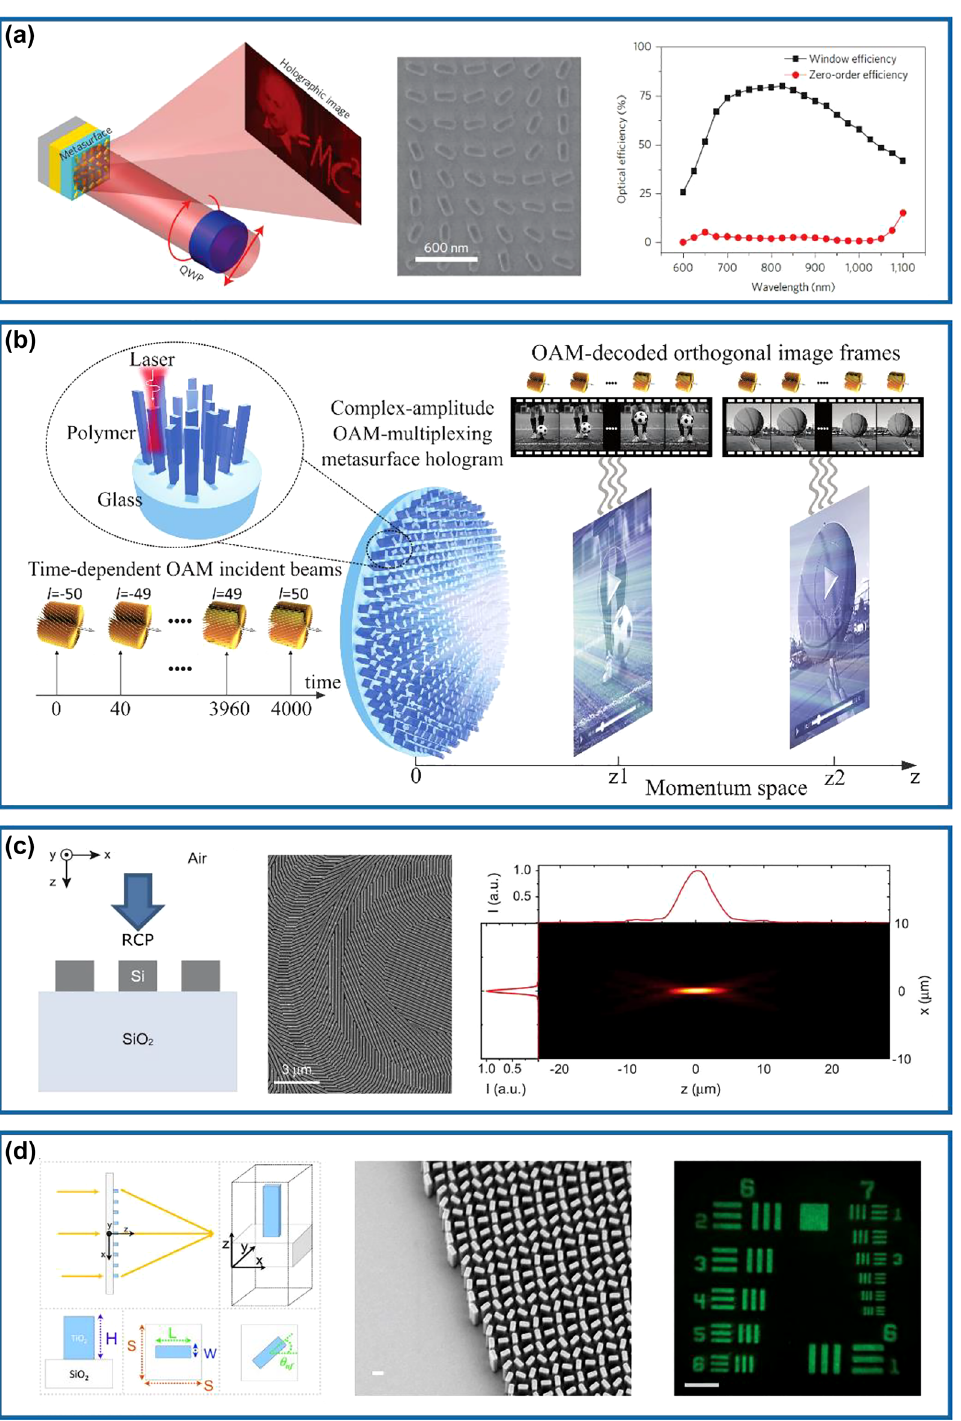
Figure 3: Multifunctional meta-HWPs using geometric phase. (a) Left panel: schematic of the reflective metasurface hologram under a CP incidentlight.Middlepanel:SEMimageofpartofthefabricatedsample.Rightpanel:measuredholographicimageandzero-orderefficiencies as a function of the wavelength. Reprinted from Ref. [59]. (b) Schematic of the complex-amplitude OAM-multiplexing metasurface hologram that displays two separate holographic videos, both carrying a large amount of OAM-dependent orthogonal image frames, at two different image planes simultaneously in the momentum space. Reprinted from Ref. [64]. (c) Left panel: schematic view of the designed Si meta-HWP. Middle panel: SEM image of part of the fabricated metalens. Right panel: measured intensity distributions of the focusing light passing through the fabricated meta-lens along the vertical and horizontal axes in the xz -plane. Reprinted from Ref. [83]. (d) Left panel: illustration of the TiO 2 metalens and its unit cell. Middle panel: SEM image of the fabricated metalens. Right panel: resolution test image formed by the fabricated metalens at λ = 530 nm. Reprinted from Ref.